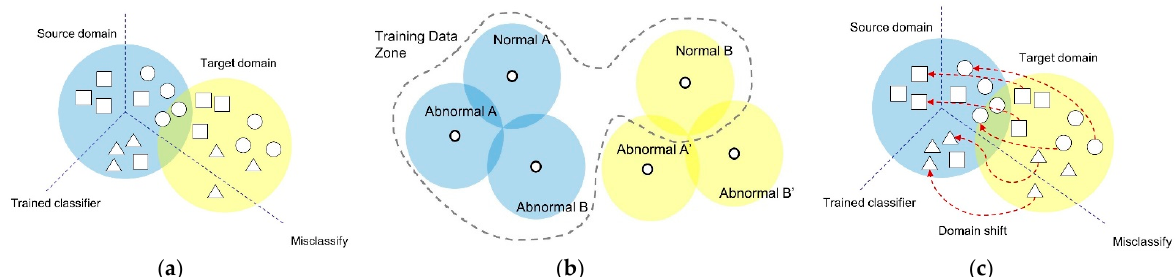
Figure 3. Visualization of the distribution concept for each domain dataset. ( a ) Before domain transformation; ( b ) the goal of domain adaptation; ( c ) training dataset of the proposed model.